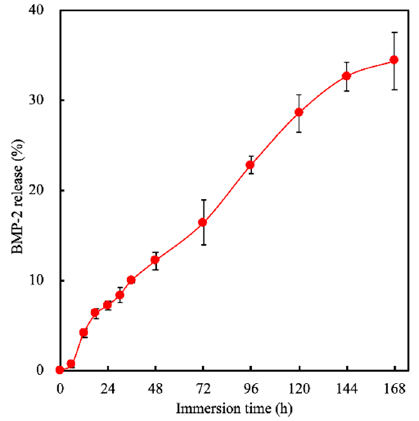
Figure 5. Bone morphogenetic protein (BMP)-2 release from FGSrB scaffold after immersion in Dulbecco’s Modified Eagle’s Medium (DMEM) at 37 °C for different time points. Data presented as mean ± SEM, n = 6 for each group.